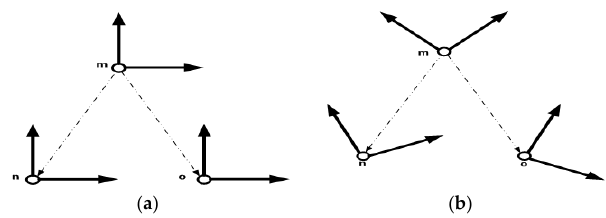
Figure 8. Formation Control Setup ( a ) Displacement based formation ( b ) Distance-based formation.